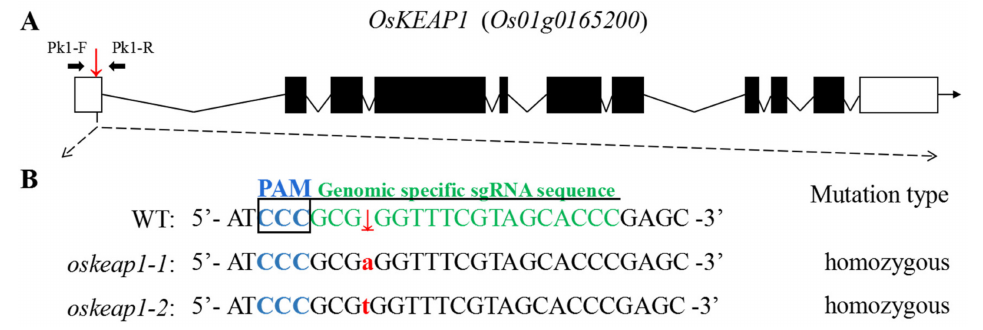
Figure 3. Targeted mutagenesis of OsKEAP1 using the CRISPR / Cas9 system. ( A ) Gene structure of OsKEAP1 with the sgRNA target shown by a frame; primers used for amplification of the fragment encompassing the target region (Pk1-F / R) are shown. ( B ) Sequence information around the target for the wild-type cultivar Xidao #1 (wild-type (WT)) and its two oskeap1 mutants, the target sequence, and its PAM are